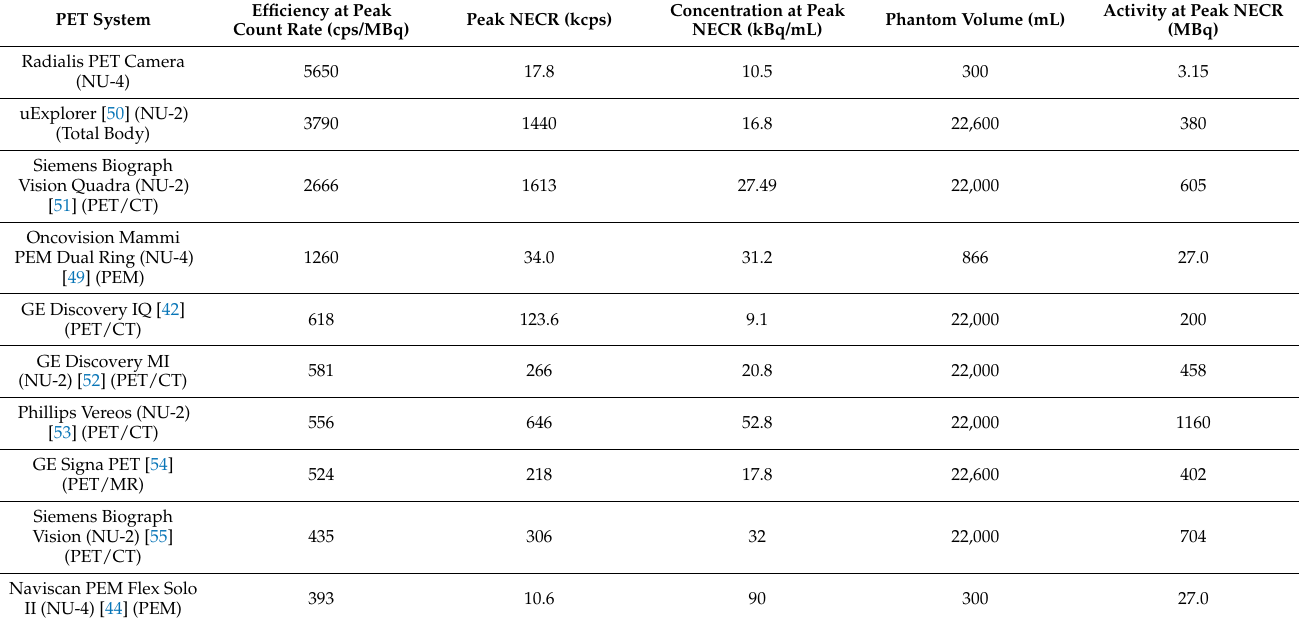
Table 4. Count rate data for several organ-targeted, whole-body and emerging total-body PET